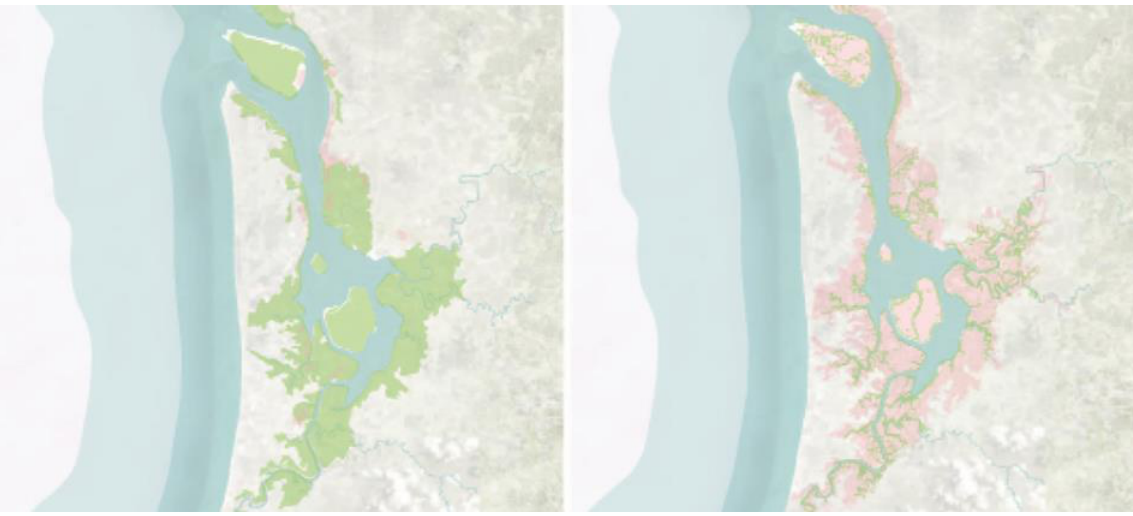
Figure A1. From 1991 ( left ) to 2016 ( right ) — Loss of Mangrove habitat (green) in favor of shrimp Farm (pink).